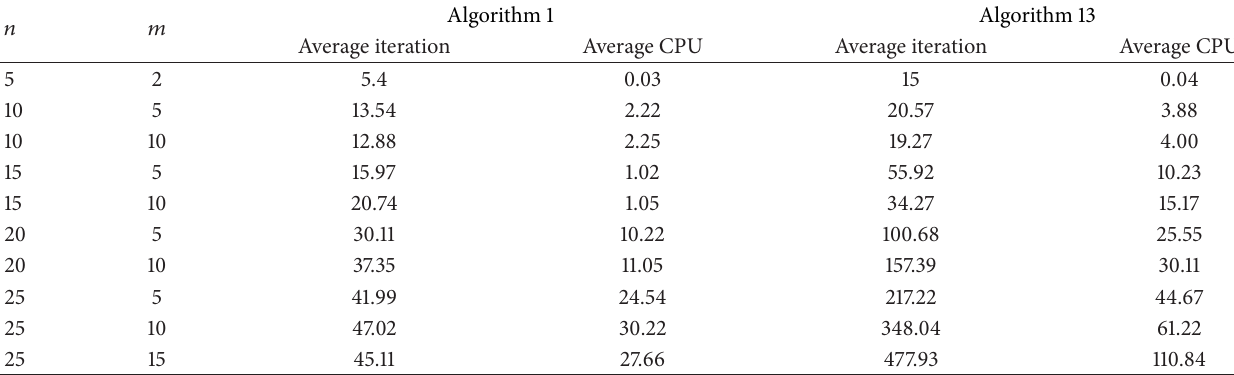
Table 1: Numerical